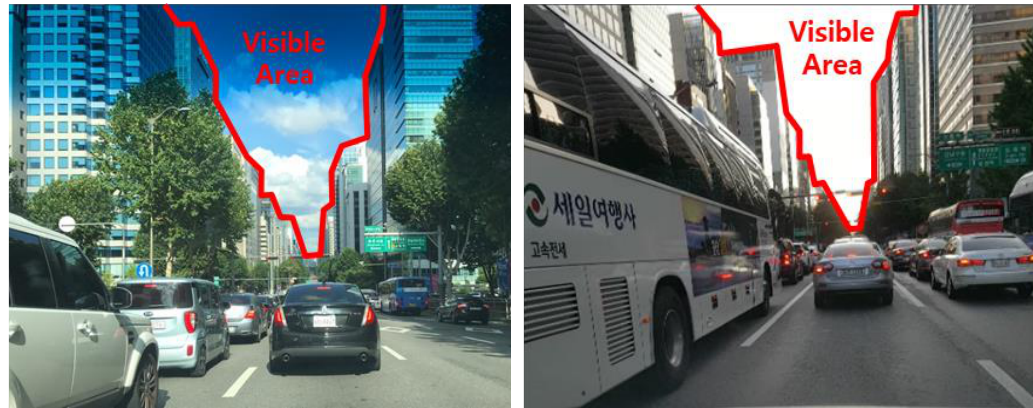
Figure 8. Teheran road in Seoul (dynamic test environment).